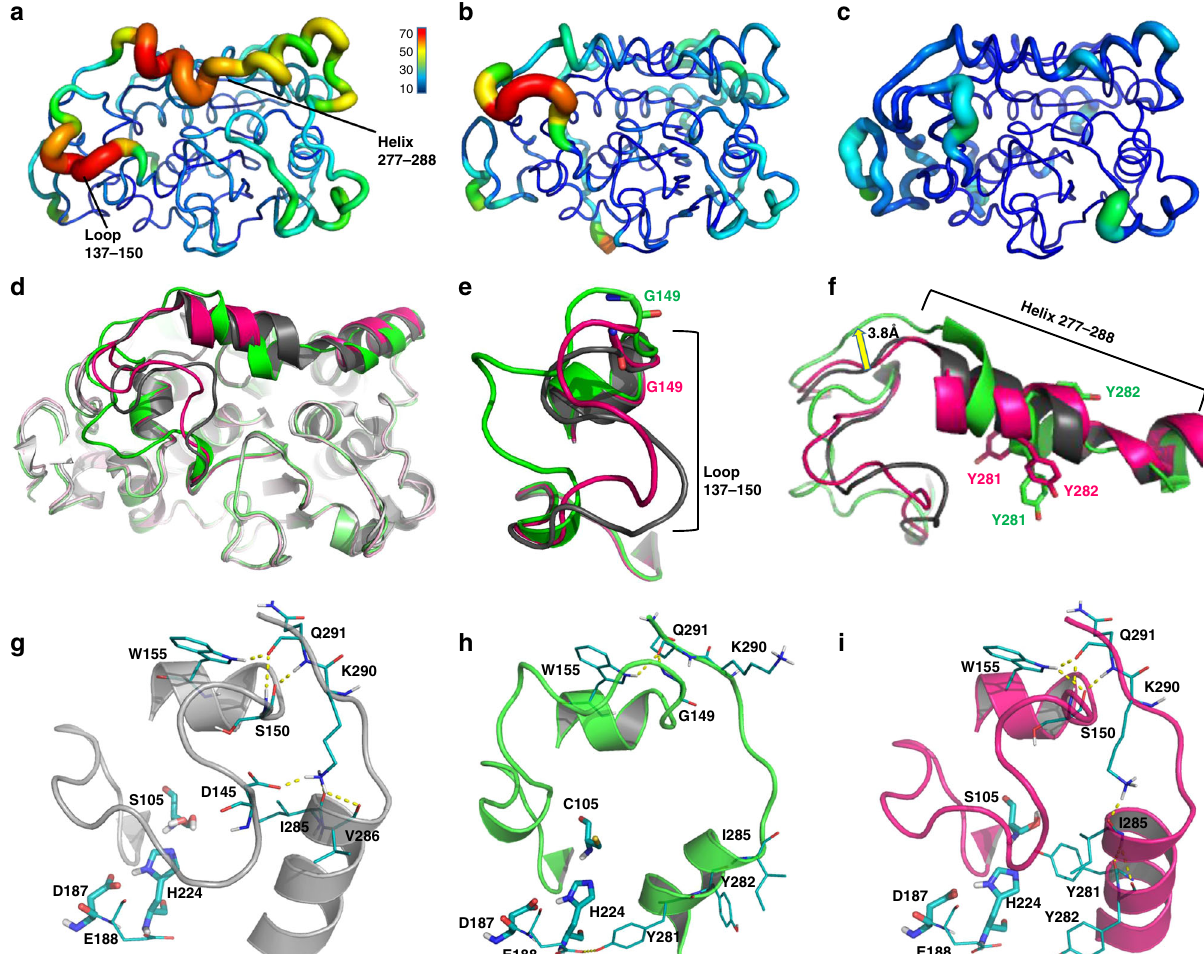
Fig. 3 Cartoon representation of the crystal structures of enzymes. a Variant QW4. b Variant QW10. c WT CALB (PDB: 5a71 21 ). a – c are colored according to the B-factor. d Superimposed overall structures of WT CALB (gray), QW4 (green) and QW10 (pink). e Zoom-in view of the loop 137 – 150 in WT CALB (gray), in QW4 (green) and in QW10 (pink). f Zoom-in view of helix 277 – 288 in WT CALB (gray), in QW4 (green) and in QW10 (pink). Hydrogen bonds formed between the α -6 helix, loop 137 – 150 and α -10 helix in g (WT-CALB), h (QW4) and i (QW10). H-bond formed between Tyr281 and Glu188 in QW4 mutant ( h ) was also